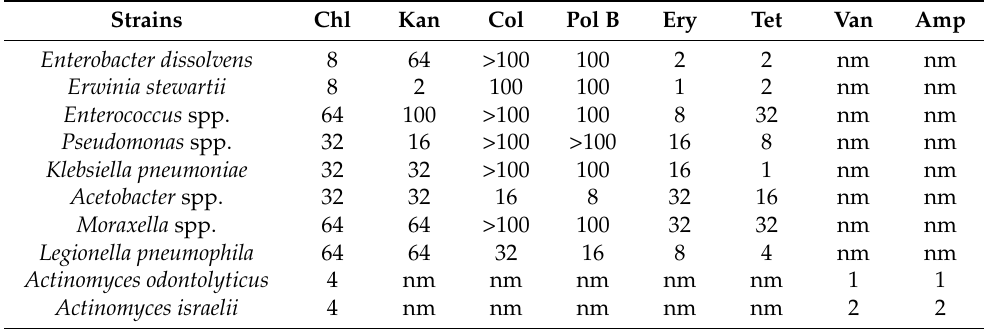
Chl: chlorhexidine; Kan: kanamycin; Col: colistin; Pol B: polymyxin B; Ery: erythromycin; Tet: tetracycline; Van: vancomycin; Amp: ampicillin. nm: not measured.